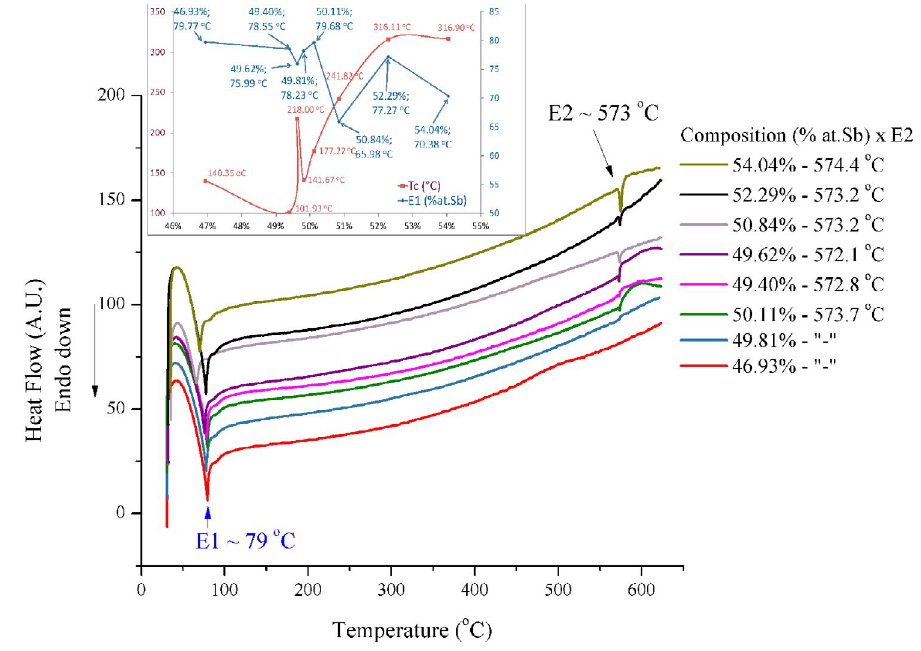
Figure 3. Heat flow x Temperature diagram - DSC data.